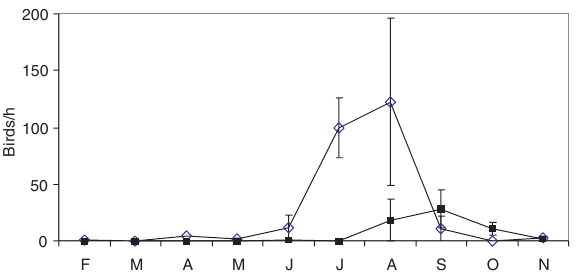
F IG . 3. – Monthly distribution (mean ± SE) of the migratory passage (birds/h) at Cape Silleiro in 1999. Open symbols = northward migration; solid symbols = southward migration.